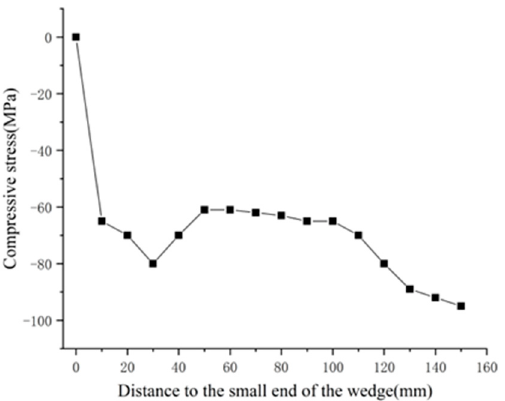
11 of 18 Figure 7. Von Mises stress distribution. Table 2. Finite element analysis results. Component